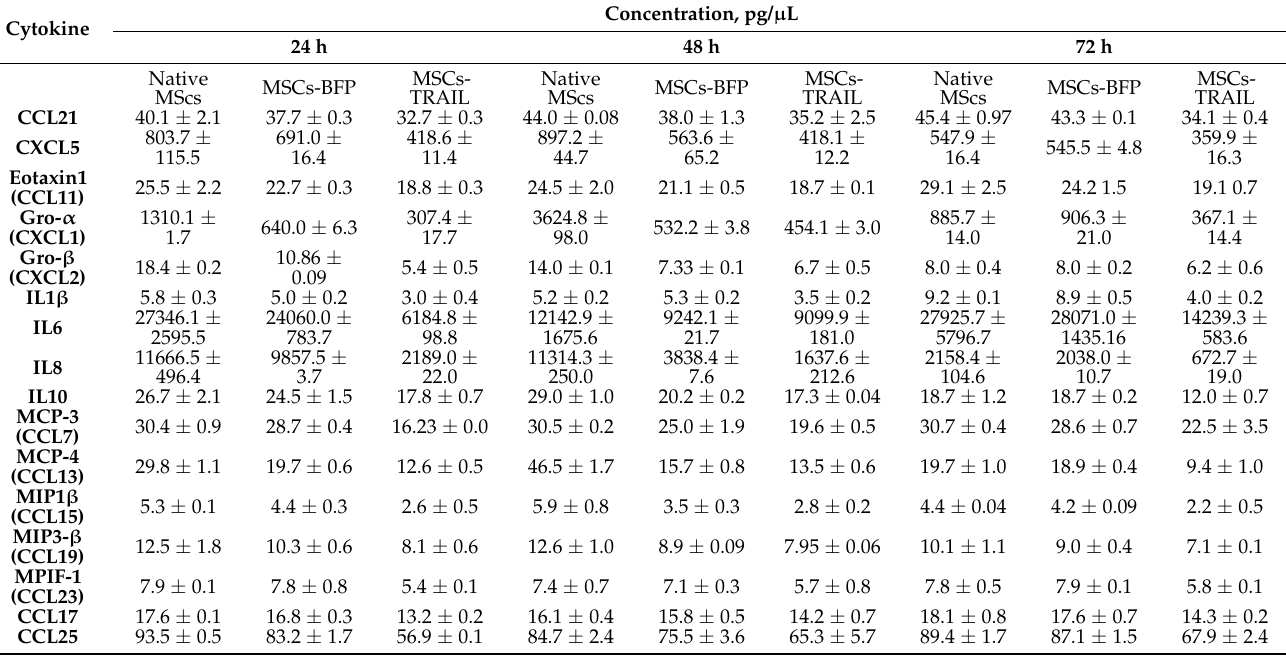
Table 2. Concentration of cytokines/chemokines in the conditioned medium of native and genetically modified